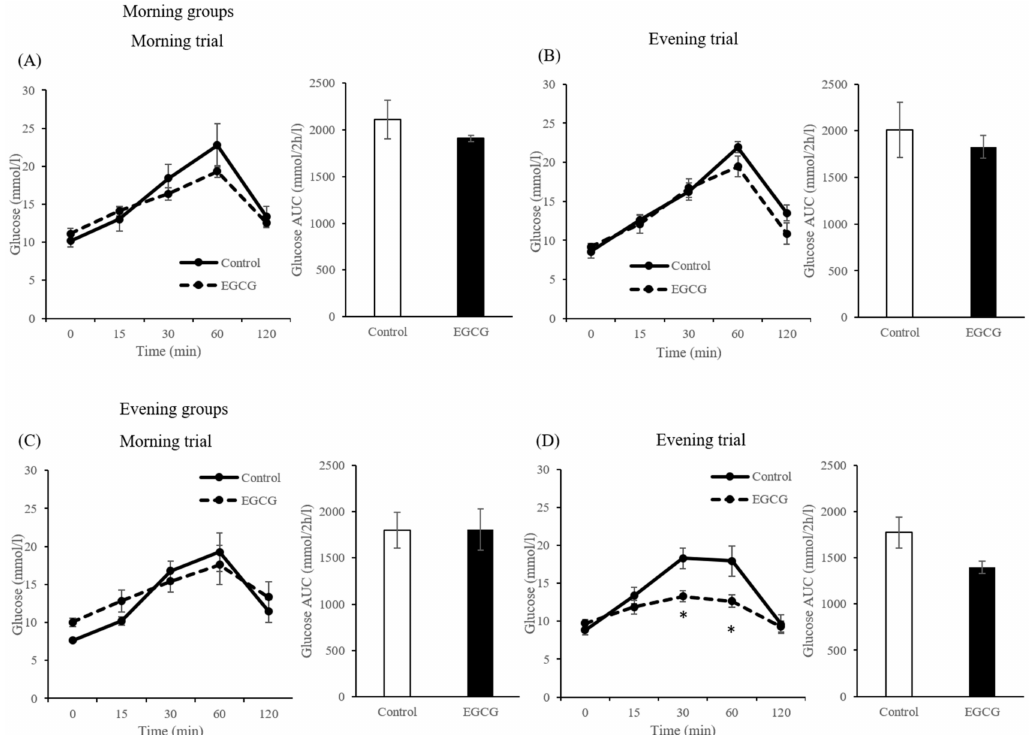
Figure 4. Concentrations and incremental area under the curve (AUC) of plasma glucose in the morning groups (( A ): morning trials, ( B ): evening trials) and evening groups (( C ): morning trials, ( D ): evening trials) in mice. Data are expressed as the mean and SEM, represented by bidirectional bars. * Mean values were significantly di ff erent from that of control group at same